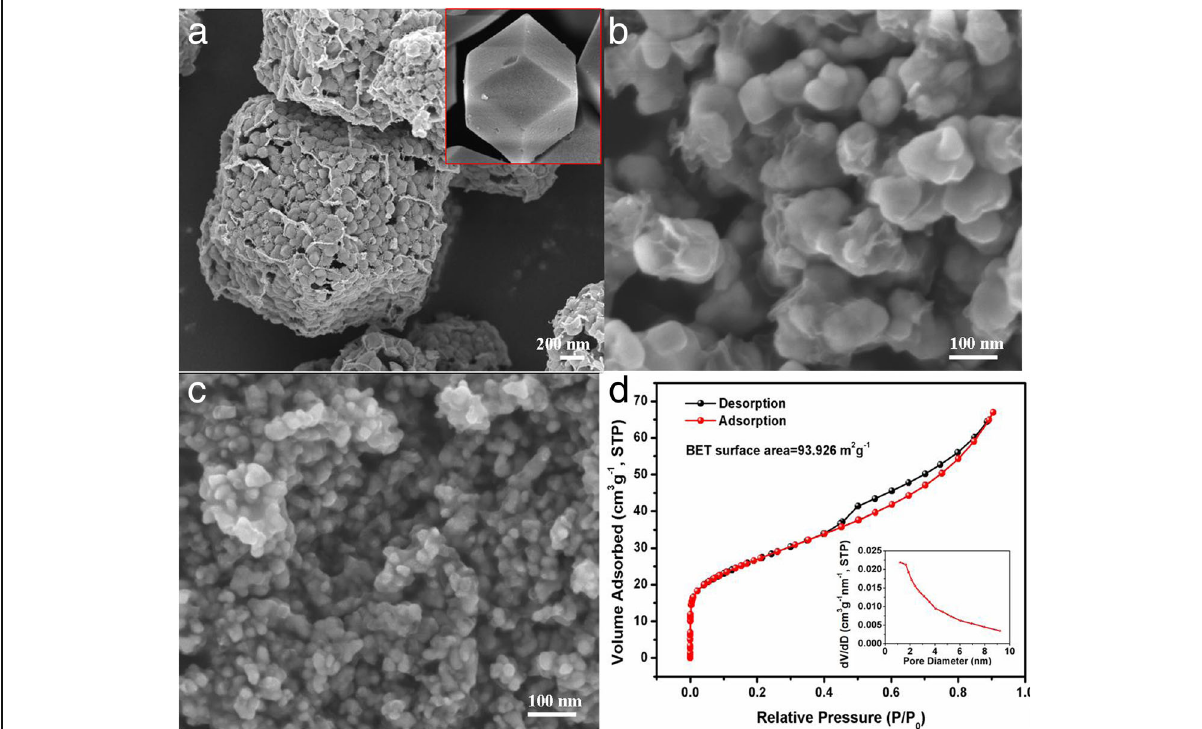
Fig. 3 a – c SEM images of ZnSe/NC-900, ZnSe/NC-300, and ZnSe/NC-40, respectively, inset of SEM image of ZIF-8. d Nitrogen adsorption-desorption isotherms of ZnSe/NC-300, inset of pore diameter distribution profiles of